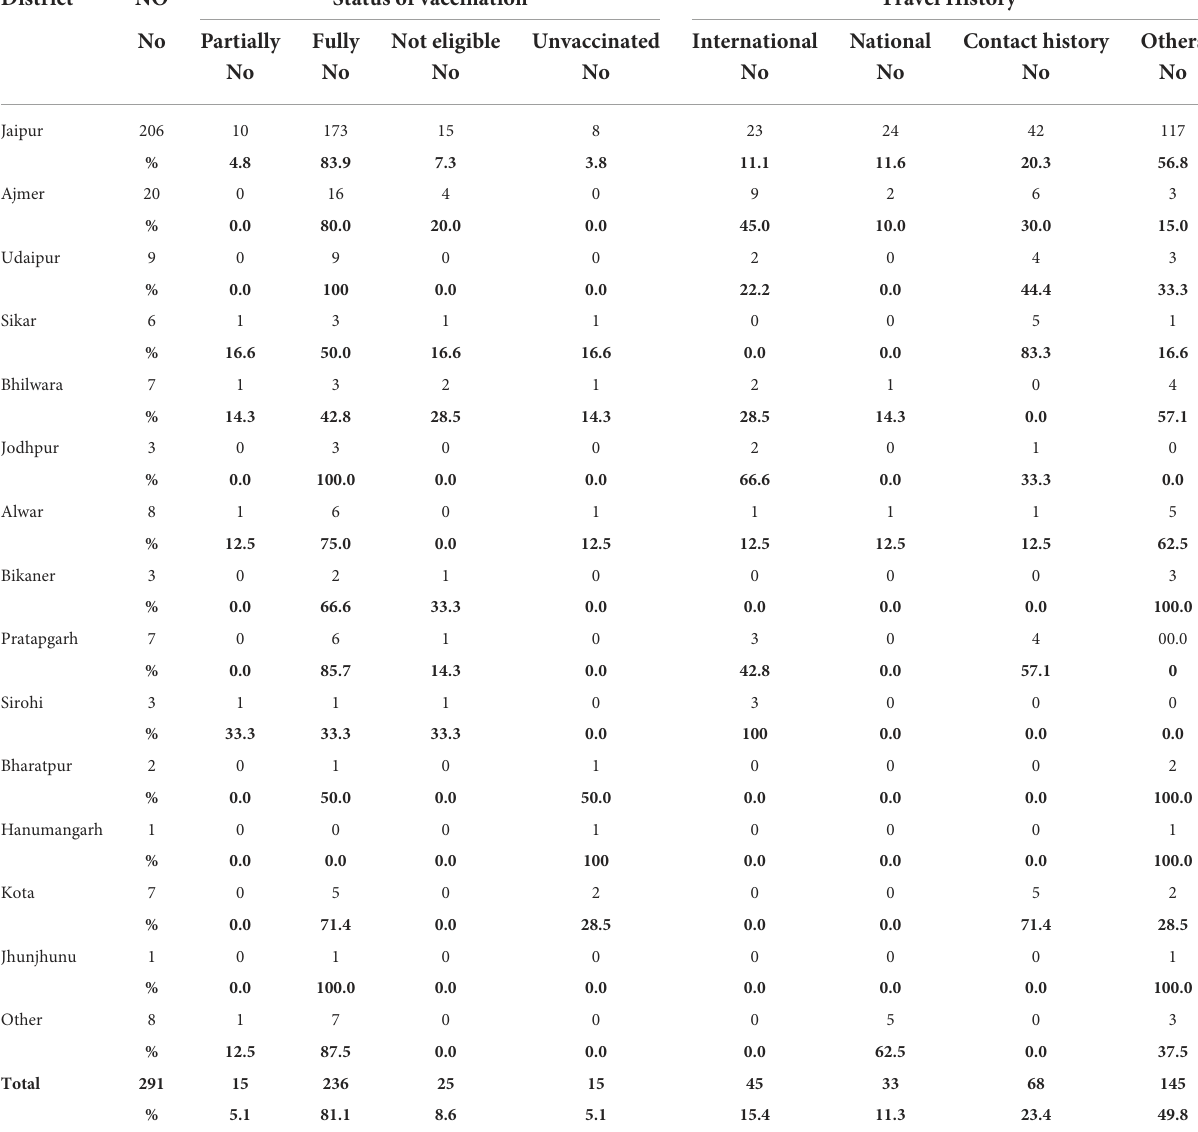
TABLE 1 International travel history in Omicron